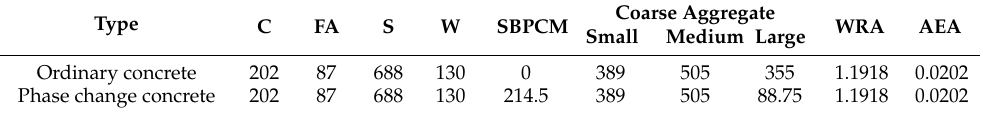
Table 4. Mix proportion of concrete modified by steel balls containing phase change material (kg/m 3